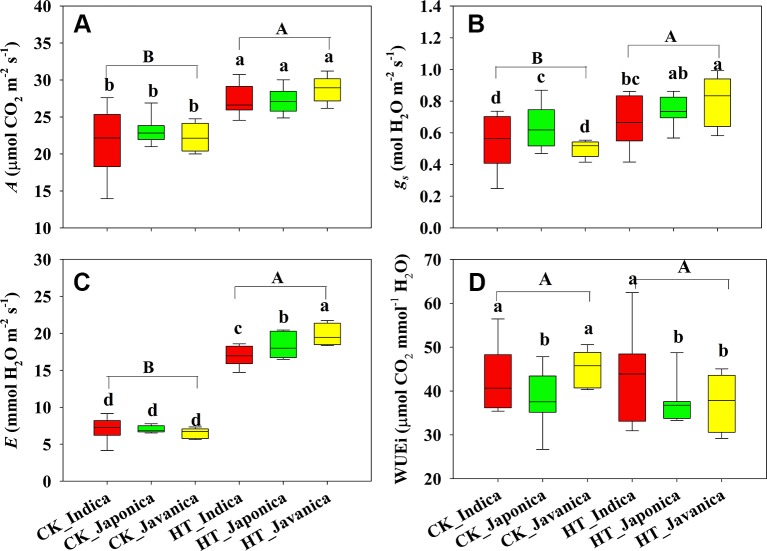
Light saturated photosynthetic rate (A, A), stomatal conductance (gs, B), transpiration rate (E, C), and intrinsic water use efficiency (WUEi, D) for the three rice (Oryza sativa L.) subspecies at high growth temperature (HT) and control (CK) treatments. Different lowercase and uppercase letters indicate significant differences between subspecies means and temperature treatments, respectively (p < 0.05). The outer box edges represent the 25th and 75th percentiles, the error bars are the 5th and 95th percentiles, and the line within the box represents the mean values. For each cultivar, three flag leaves were measured (one leaf per plant), and the three values were averaged as one biological replicate. n (the biological replicates) was 8, 8, and 5 for the indica, japonica, and javanica cultivars, respectively.